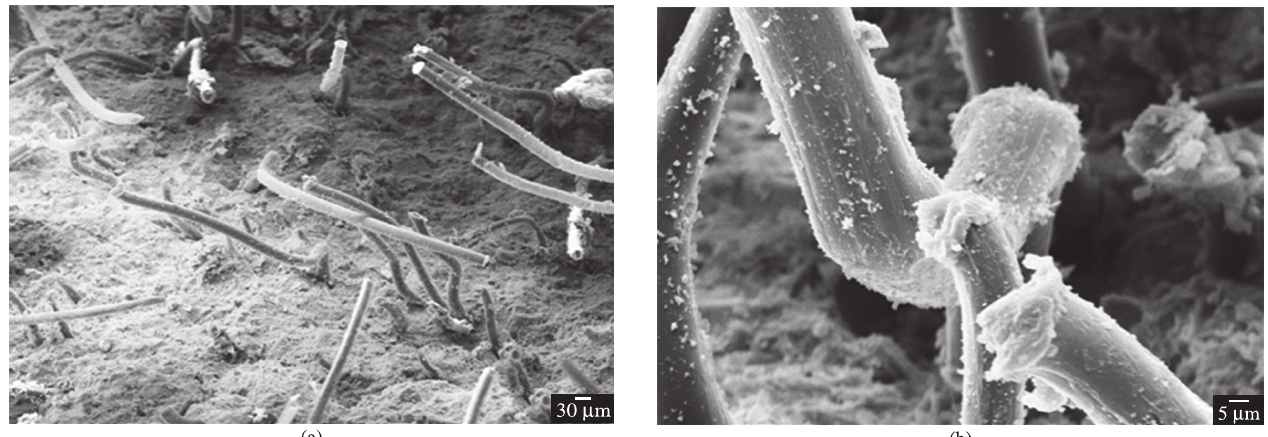
Figure 9. SEM of fracture surface of composites after 100 soak/dry cycles: a) and b) sisal organosolv pulp + PP